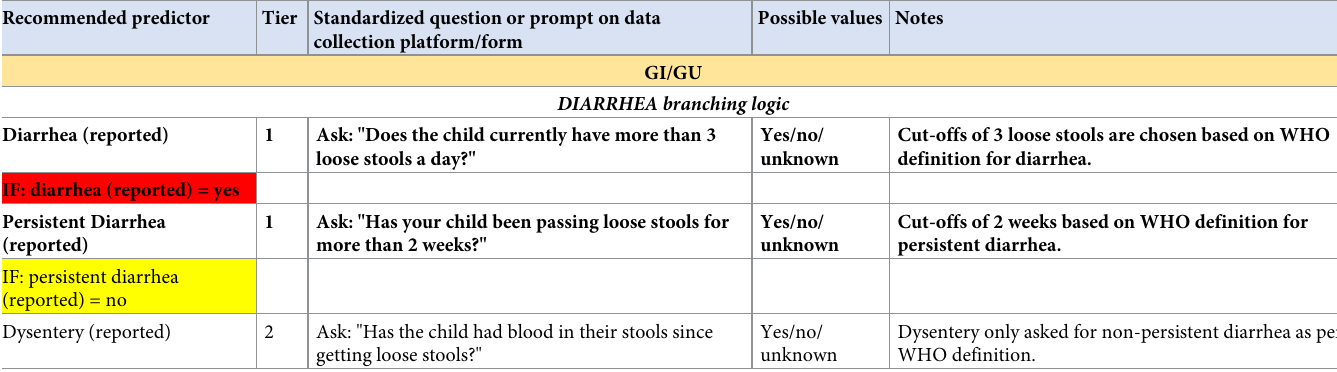
Table 3. Sample branching logic to elucidate diarrhea timeline as per World Health Organization definitions. Recommended